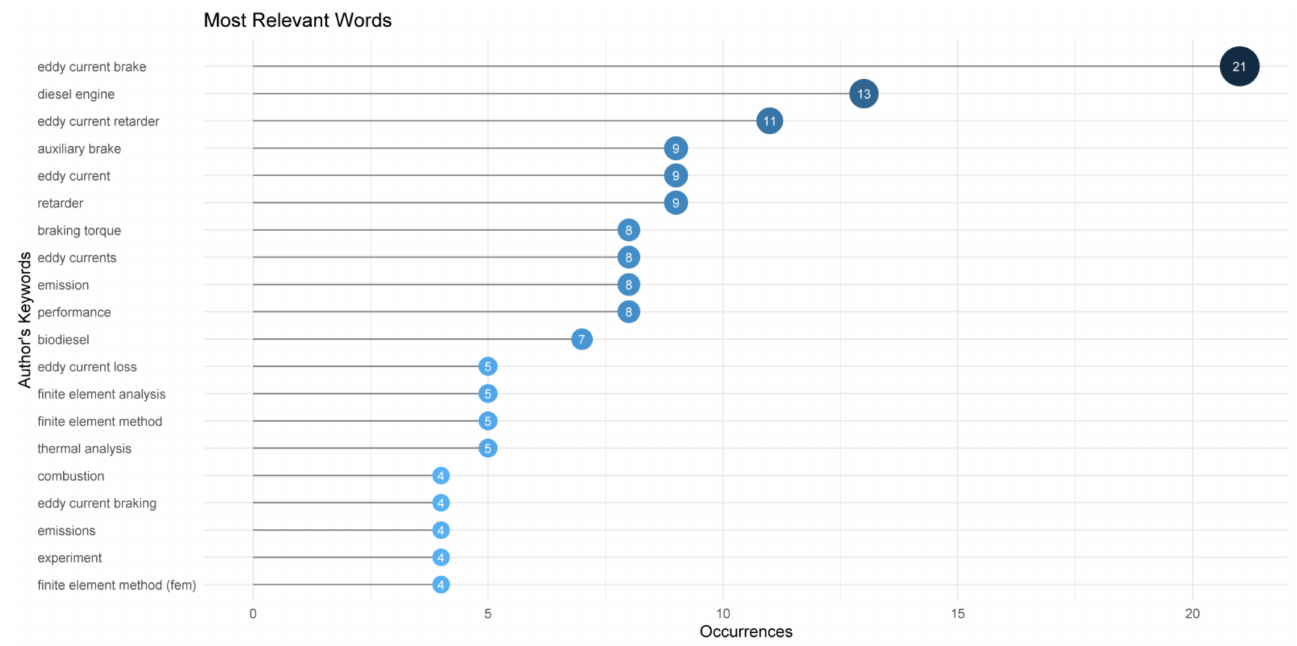
Figure 9. Most relevant